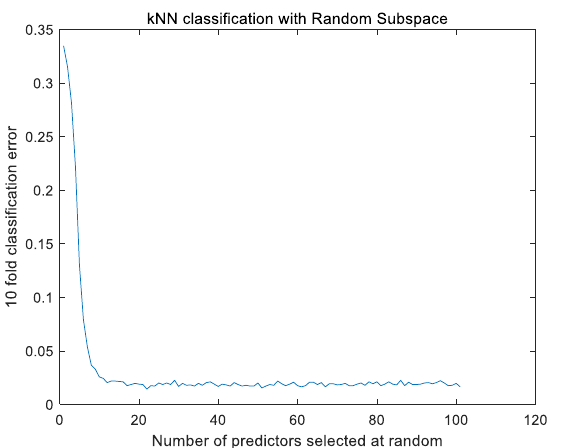
Figure 11. Number of predictors selected at random vs. 10-fold classification error for k = 1.